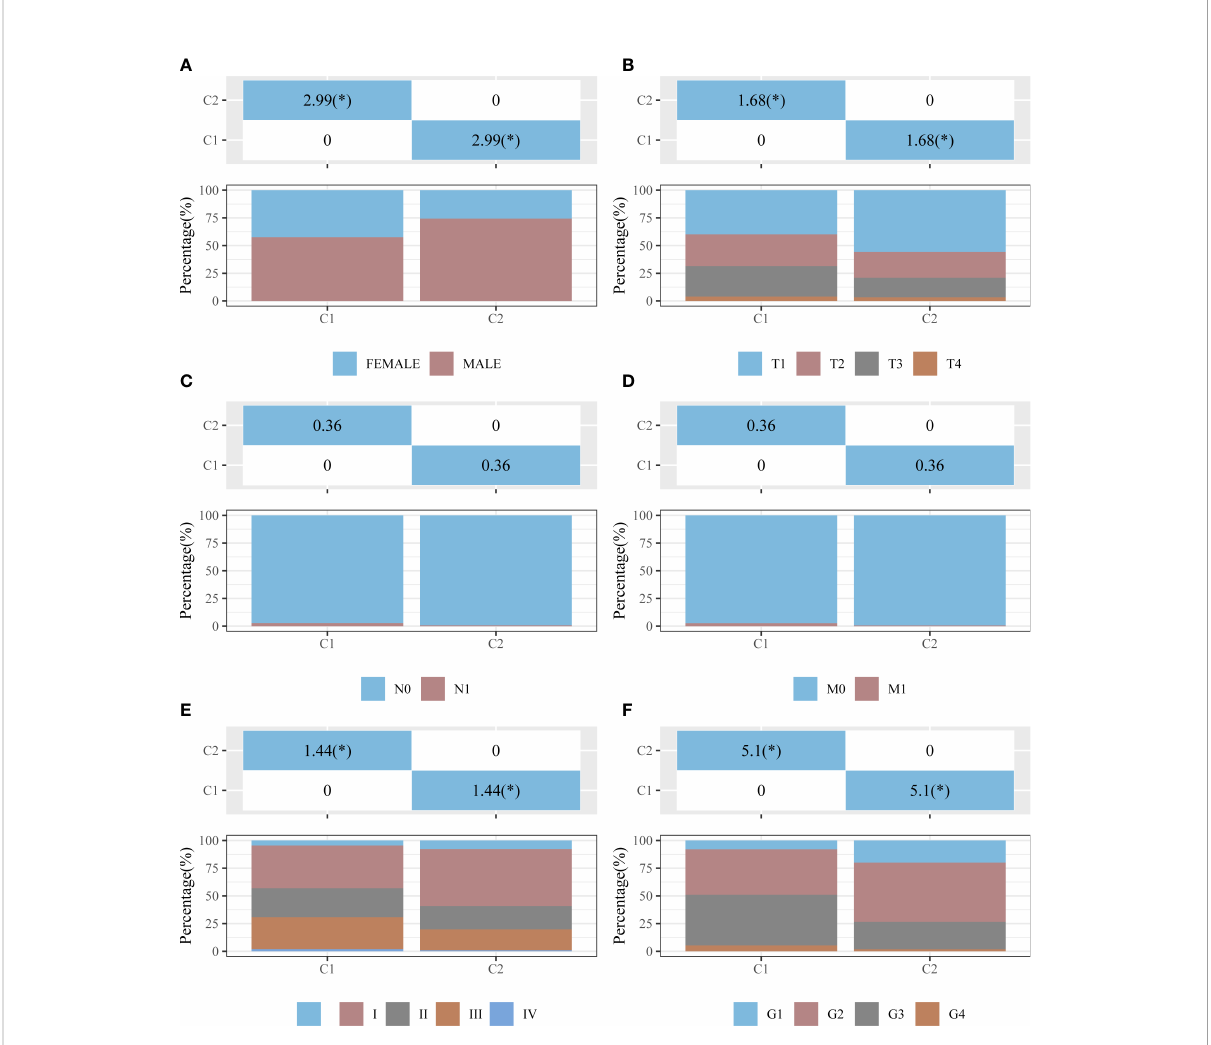
FIGURE 4 Distribution of clinical characteristics between clusters C1 and C2. Distributions in terms of sex (A) , T stage (B) , N stage (C) , M stage (D) , clinical stage (E) , and pathological grade (F) of clusters C1 and C2. The horizontal axis represents a group of samples, whereas the vertical axis represents the percentage of clinical information contained in the corresponding grouped samples. In the table, the p -value ( − log10) of clinical feature signi fi cance is shown (based on chi-square test). * p <